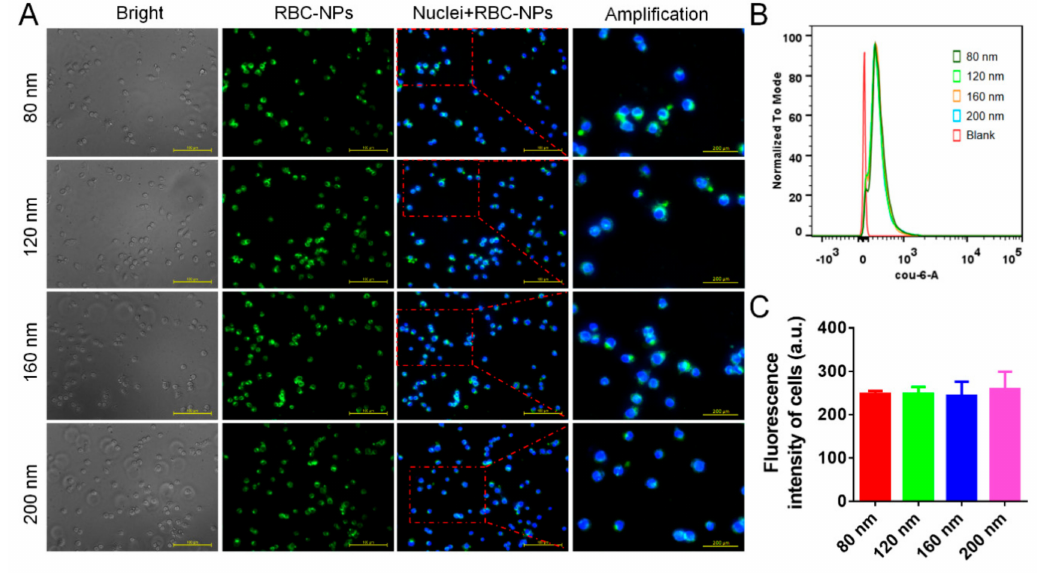
Figure 3. Cellular uptake experiment. ( A ) Fluorescence images of cellular uptake of four di ff erent-sized RBC-NPs by RAW 264.7 cells. ( B ) Flow cytometry and ( C ) corresponding quantitative results of cellular uptake of four di ff erent-sized RBC-NPs by RAW 264.7 cells ( n =